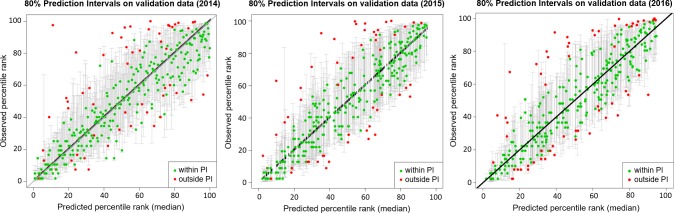
The predicted percentile ranks and its 80% prediction interval for 2014 to 2016 (left to right).In each panel, the green circles indicate the predicted percentile ranks that fall within the prediction intervals and the red circles indicate the predicted percentile ranks that fall outside the prediction intervals.